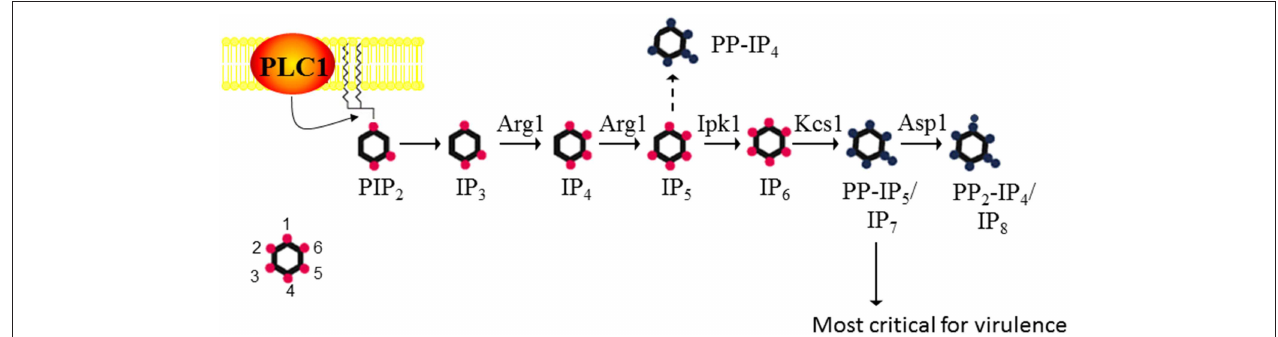
FIGURE 1 | The inositol polyphosphate biosynthesis pathway in C. neoformans . PLC1 –derived IP 3 is sequentially phosphorylated to IP 4 , IP 5 , and IP 6 by Arg1 and Ipk1. Kcs1 generates PP-IP 4 and PP-IP 5 /IP 7 from IP 5 and IP 6 , respectively. However, PP-IP 4 is only detected in the absence of Ipk1 (hence the dashed line). PP 2 -IP 4 is derived from Asp1. The insert represents the position of the phosphates on the inositol ring. Figure was adapted from Lev et al. (2015), Li et al. (2016).